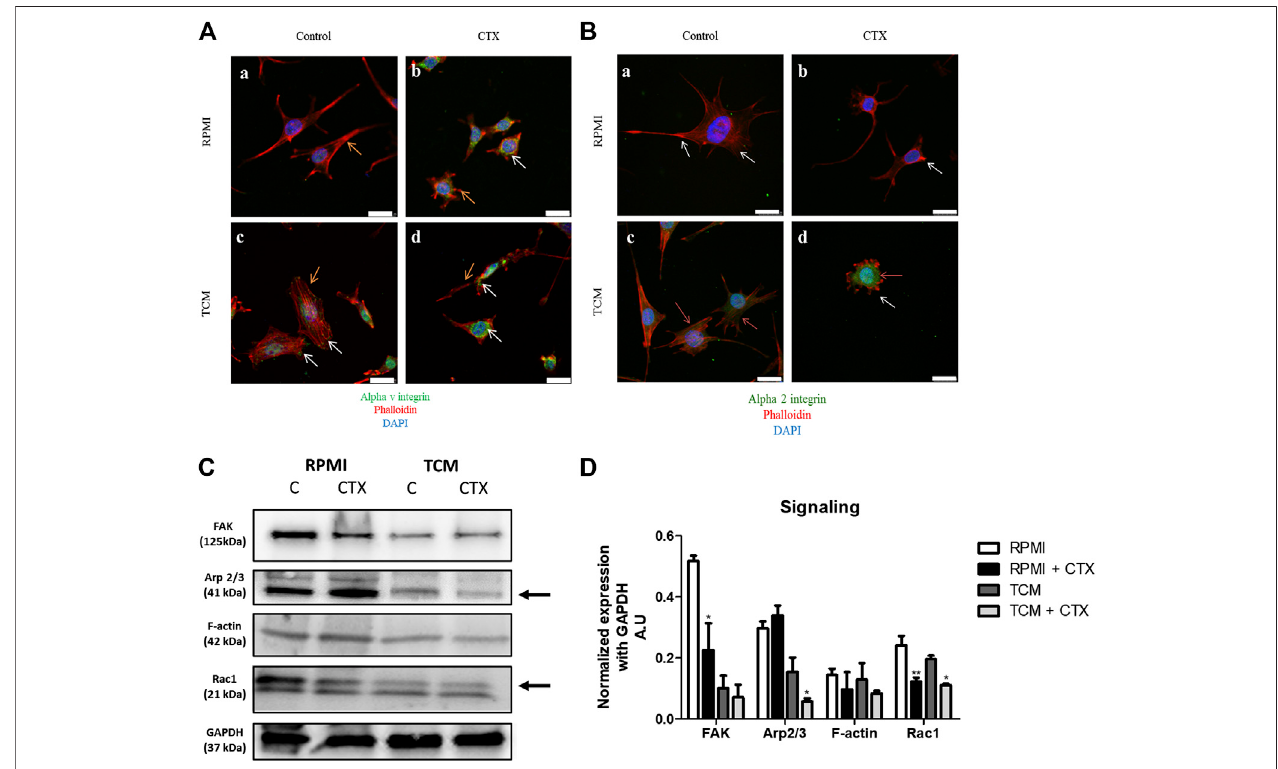
FIGURE 6 | Effect of CTX on actin cytoskeleton, intracellular signaling and integrin expression in t.End.1 endothelial cells in the different microenvironments. In (A) , marking of α v subunit (green) and F-actin (red) of control cells incubated with RPMI 1640 medium (a) or MCF-7-CM (b) . CTX-treated cells are labeled in (b , d) . In (B) , marking of α 2 subunit (green) and F-actin (red) of control cells incubated with RPMI 1640 medium (a) or MCF-7-CM (b) . CTX-treated cells are labeled in (b , d). Orange arrows represent the expression of α v and α 2 in the cell (green); White arrows represent the cytoskeleton protrusions (red). For details of the experiments, please see the Materials and Methods section. Scale bar: 25 μ m. Western blotting was performed for the analysis shown in (C) , integrin-mediated signaling: FAK, Arp2/3, F-actin and Rac-1 expression levels. The values were normalized by GAPDH expression and band intensities were quanti fi ed by densitometry of the homogenate western blots and represented the mean ± s.e.m. for three samples per group and represent three separate assays (D) . * p < 0.05 by comparison with the respective control groups. ** p < 0.01 by comparison with the respective control groups. *** p < 0.001 by comparison with the respective control groups.